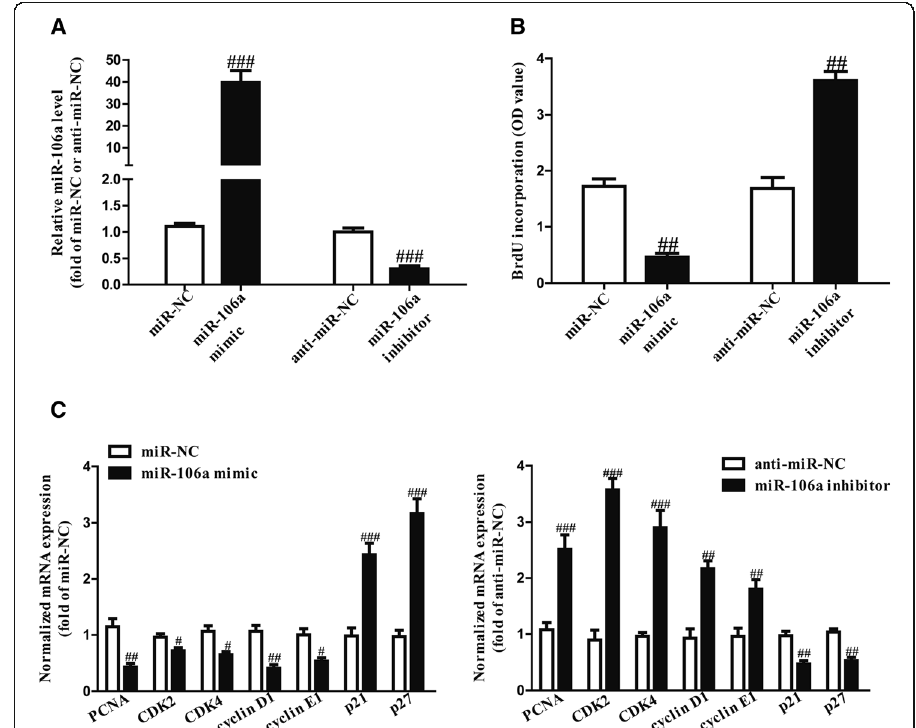
Fig. 4 The effects of miR-106a on proliferation and related molecules in OSCC cells. SCC4 cells were transfected with the miR-106a mimic or inhibitor for 48 h. a The level of miR-106a was detected via quantitative RT-PCR. b Cell proliferation was assessed with a BrdU-ELISA assay. c The mRNA expressions of PCNA, CDK2, CDK4, cyclin D1, cyclin E1, p21 and p27 were determined via quantitative RT-PCR. All data are presented as means ± SEM, n=6. # p<0.05, ## p<0.01, ### p<0.001 vs. miR-NC or